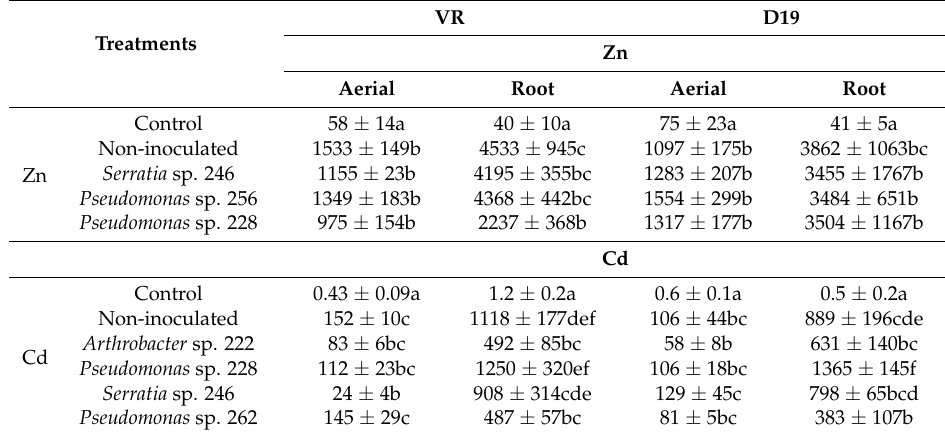
Table 2. Total metal concentrations (mg · kg − 1 dry matter) in two cultivars of H. tuberosus grown in absence (control) and in presence of 1 mM Zn or 0.1 mM